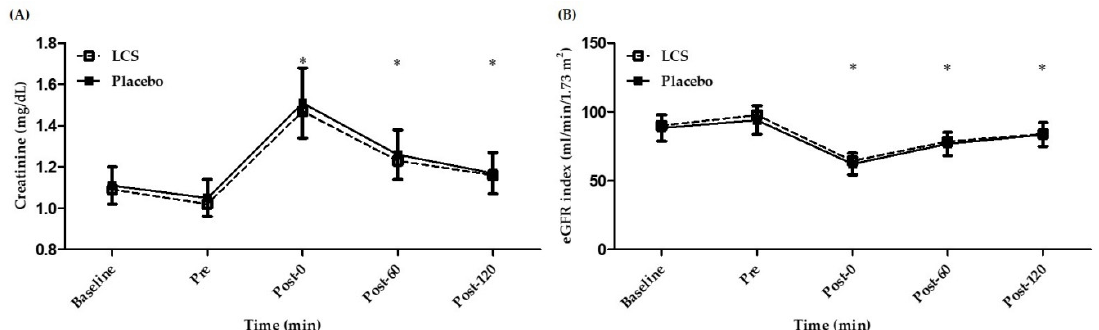
Figure 3. Changes in ( A ) creatinine and ( B ) estimated glomerular filtration rate (eGFR) after